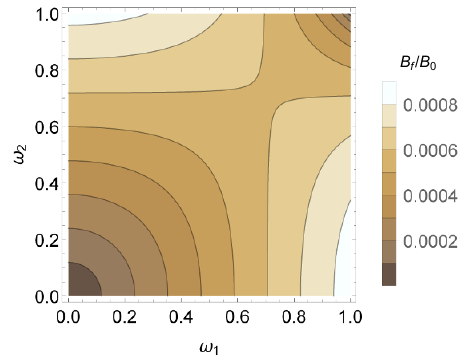
Figure 10 . (color online). (a) Change in B ( (cid:28) = 5 fm = c ; x = y = L; (cid:17) = 0) with respect to ! 1 and ! 2 . The maximum happens at ! 1 = ! 2 line. (b) Temporal evolution of the regularized magnetic (cid:12)eld for di(cid:11)erent values of ! 2 . Other parameters are